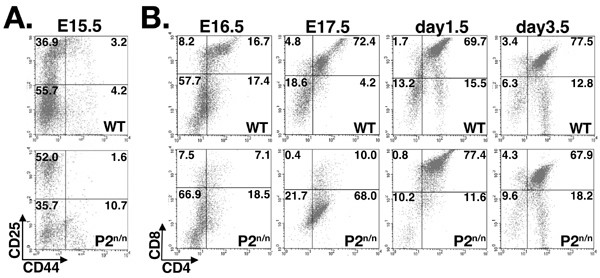
P2-mediated expression of Runx1 is required for embryonal thymopoiesis. (A) Distribution of CD44/CD25 expressing thymocytes of E15.5 WT and P2neo/neo embryos. Representative data of five different experiments are shown as FACS dot plots; percentages of cells in each quadrant are indicated. (B) Distribution of embryonic and neonatal CD4/CD8 thymocytes. WT and P2neo/neo thymocytes of E16.5 and E17.5 embryos and day 1.5 and 3.5 neonates were analyzed. Representative data of five different experiments are shown as FACS dot plots; percentages of cells in each quadrant are indicated.